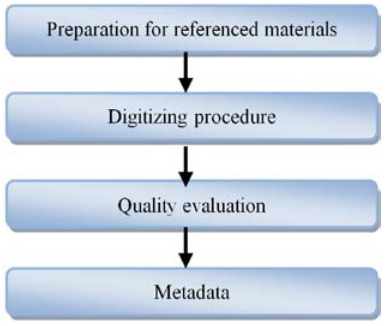
Figure 1 The major steps of digitizing process.